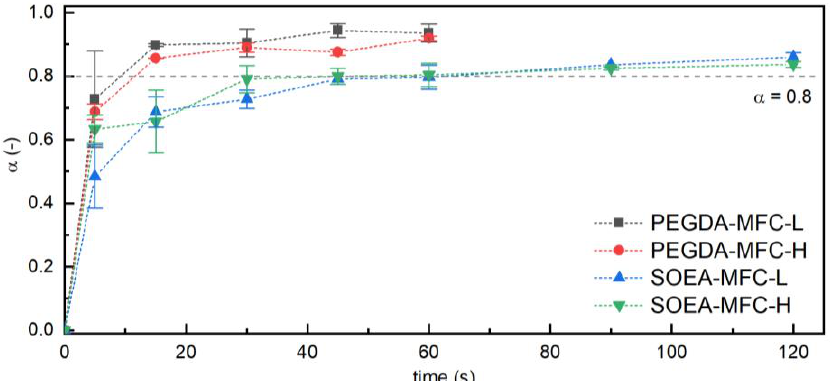
Figure 5. Conversion α of acrylic double bonds as a function of time for PEGDA-MFC composites and SOEA-MFC composites. Lines connect the experimental points and are only a guide for the eyes. The dashed horizontal line indicates a conversion α = 0.8.